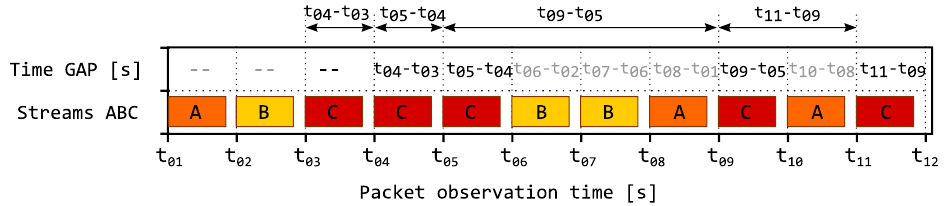
Figure 2. Example of using IPGA: analysis of time difference between two consecutive